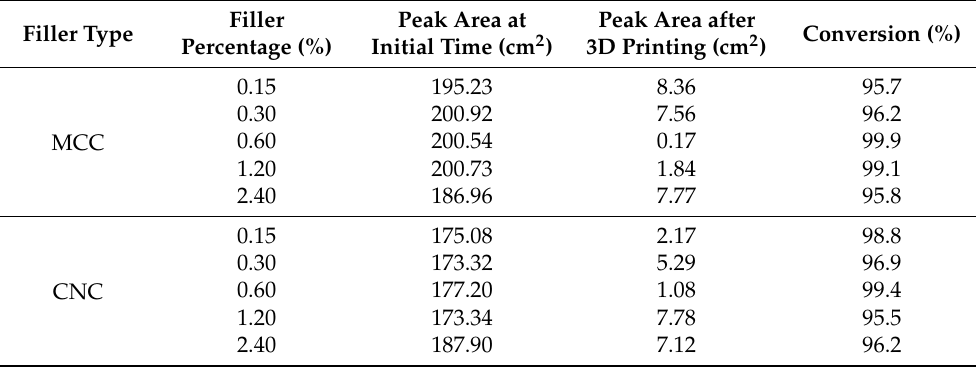
Table 3. Double-bond conversion at 810 cm − 1 in the presence of different loadings of MCCs and CNCs in P.A.20:80.